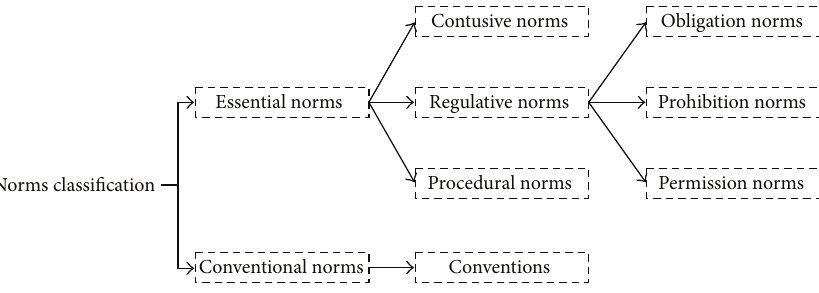
Figure 1: Norms classification